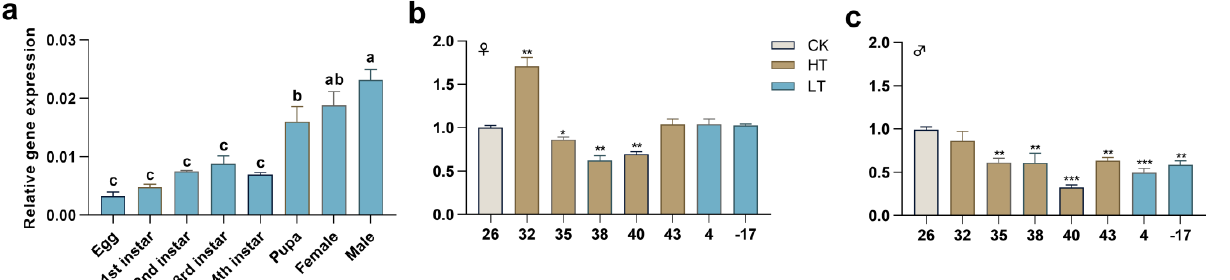
Figure 3. The expression patterns of PxTret1-like in Plutella xylostella . ( a ) Expression development patterns of PxTret1-like ; ( b ) expression of PxTret1-like in female adults treated at different temperatures (32 ◦ C, 35 ◦ C, 38 ◦ C, 40 ◦ C, 43 ◦ C, 4 ◦ C, − 17 ◦ C); ( c ) expression of PxTret1-like in male adults treated at different temperatures (32 ◦ C, 35 ◦ C, 38 ◦ C, 40 ◦ C, 43 ◦ C, 4 ◦ C, − 17 ◦ C). The Student–Newman– Keuls test was used to analyze the expression of Pxtret1-like at different developmental stages. The independent-samples t -test was used to analyze the expression of PxTret1-like in female and male adults subjected to stress at different temperatures. Error bars represent standard error of the mean. Different letters indicate significant differences in expression levels. * indicates p < 0.05; ** indicates p < 0.01; *** indicates p < 0.001.